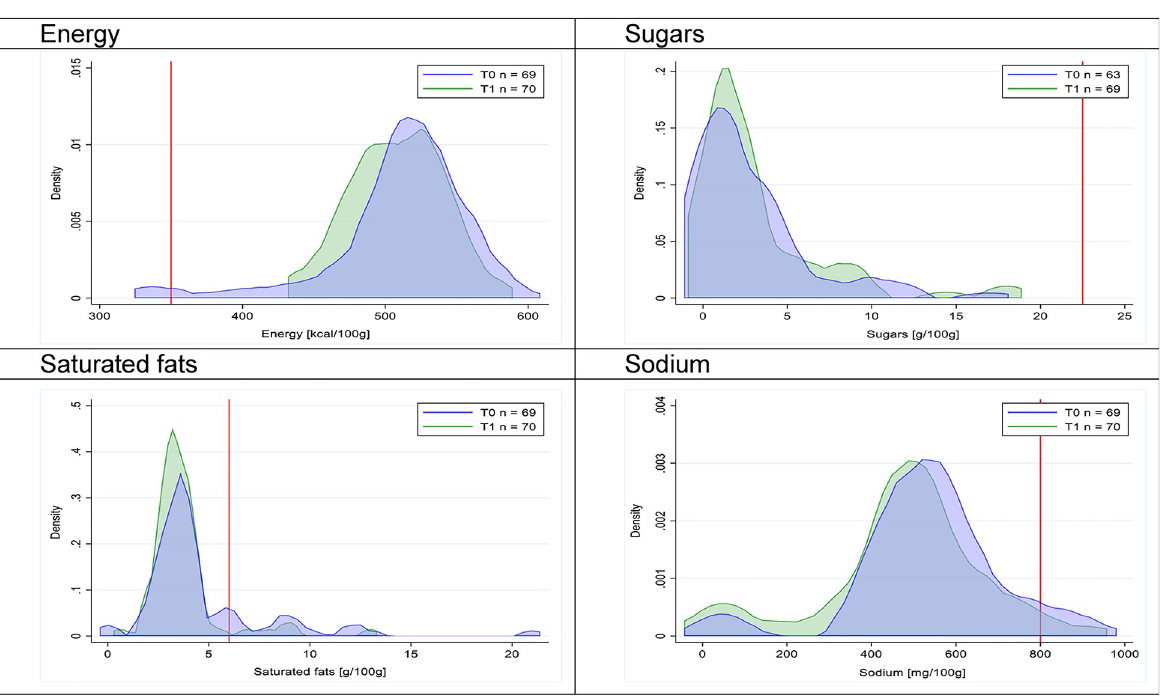
Fig 11. Density curves for the amount of energy and nutrients of concern in savory snacks, cross-sectional samples. The blue line represents the distribution in T0 (preimplementation), the green line represents the distribution in T1 (postimplementation), and the red line represents the cutoff for the amount of energy or nutrients of concern.